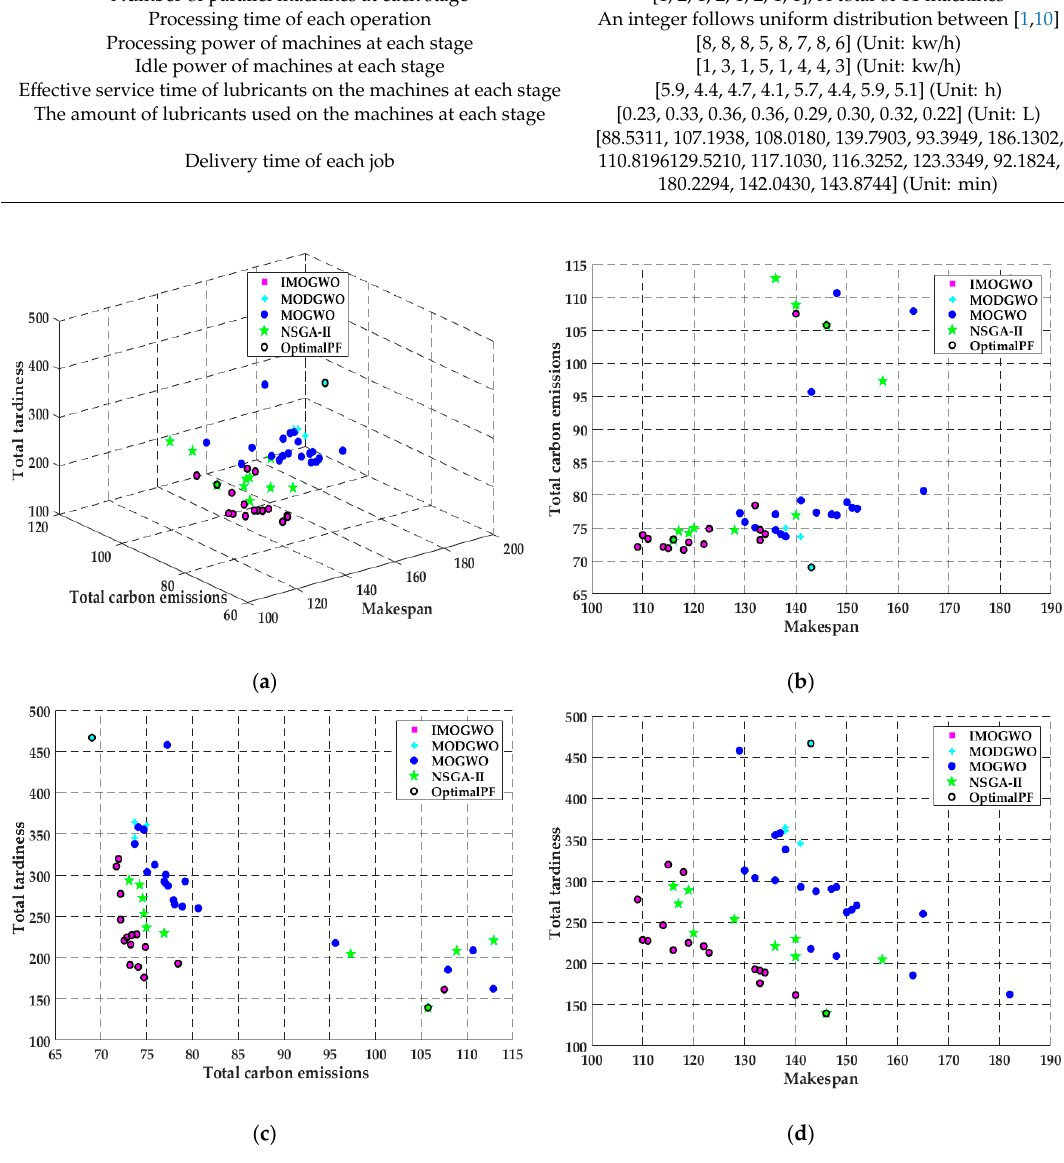
Figure 7. Pareto optimal fronts obtained by each algorithm.(a) 3D map of Pareto fronts. (b) Comparison of Makespan and Total carbon emissions. (c) Comparison of Total tardiness and Total carbon emissions. (d) Comparison of Makespan and Total tardiness.